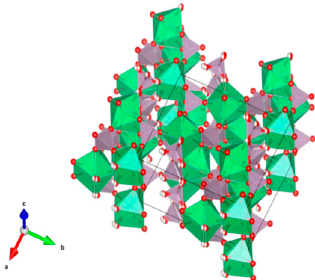
Figure 29. Thorium phosphate / Diphosphate (TPD). Th 4 (PO 4 ) 4 P 2 O 7 . Structure orthorhombic. Sp.